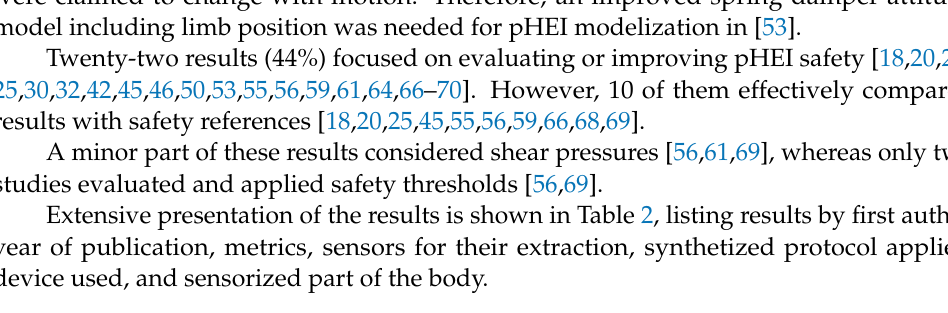
Table 1. Results including questionnaires with the related extracted metrics.